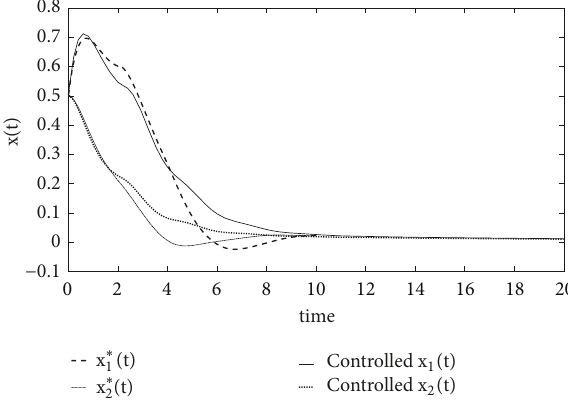
Figure 4: Optimal and suboptimal states trajectories.